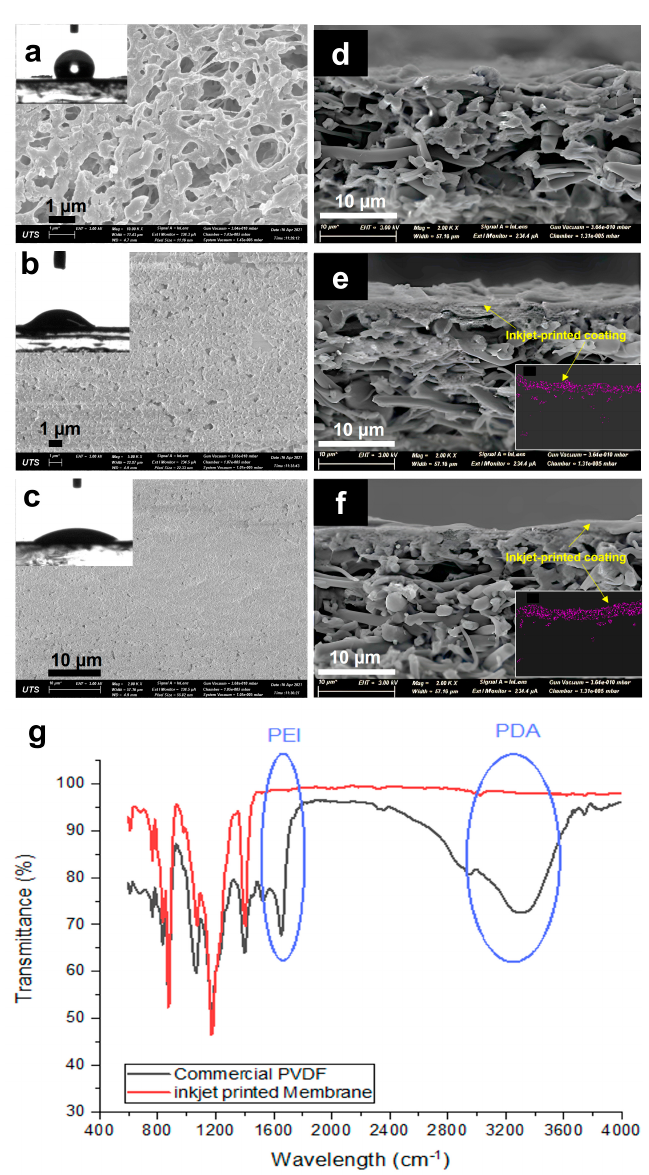
Figure 3. SEM images of the top ( a – c ) and cross-sectional ( d – f ) surfaces of the ( a , d ) commercial PVDF membrane, ( b , e ) 1-P membrane, and ( c , f ) 3-P membrane. ( g ) FTIR spectra of the commercial PVDF and inkjet-modified membrane (3-layers). Inset images of ( a – c ) show the corresponding water contact angles of the membranes, while inset images of e and f present the EDS mapping of Na on the coated hydrophilic layer of 1-P and 3-P membranes.